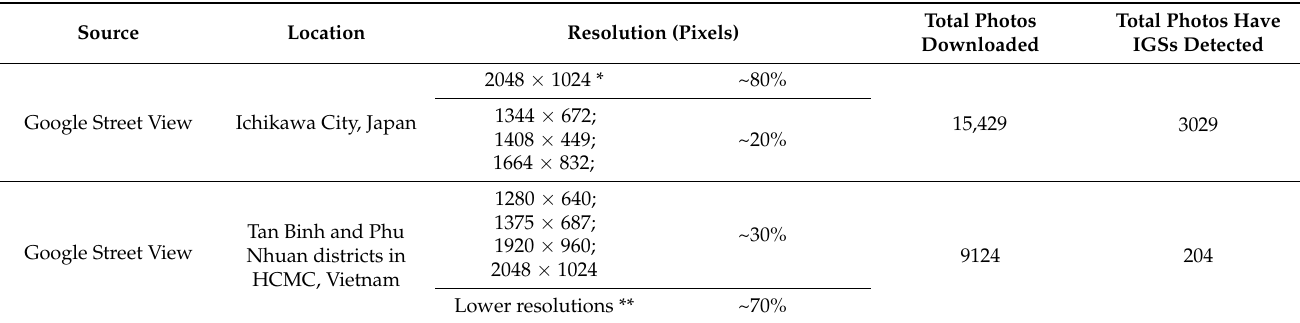
Table 1. The quality level and number of photos collected in this study.